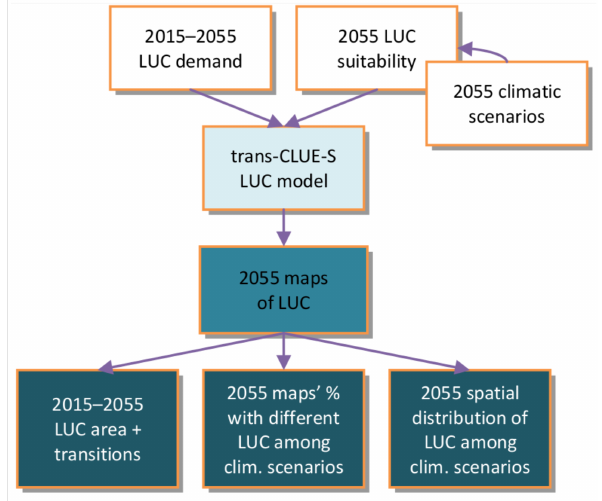
Figure 2. Basic workflow of our approach to predict and analyse future LUC in the study area. The same workflow was followed during the validation of the LUC change model against the reference map of the latest historical year 2015. From lighter to darker fill, the boxes represent different types of input or output: basic input for the LUC change model (white fill); LUC change modelling (light-shaded fill); maps predicted by the model (dark-shaded fill); and analyses of predicted maps (darker-shaded fill with bright